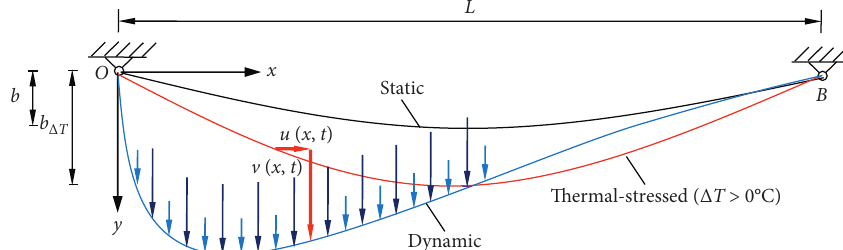
Figure 1: A schematic figure of a suspended cable in thermal